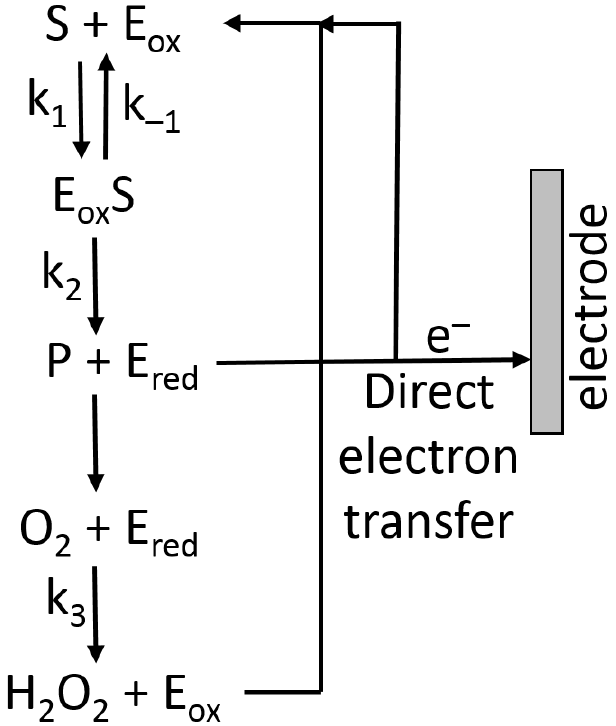
Figure 16. Kinetic steps of oxidase enzyme catalysis.